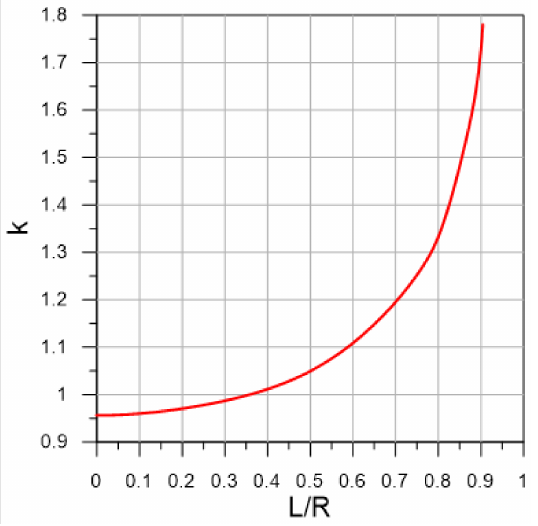
Figure 4. Dependence of the calibration constant on the distance